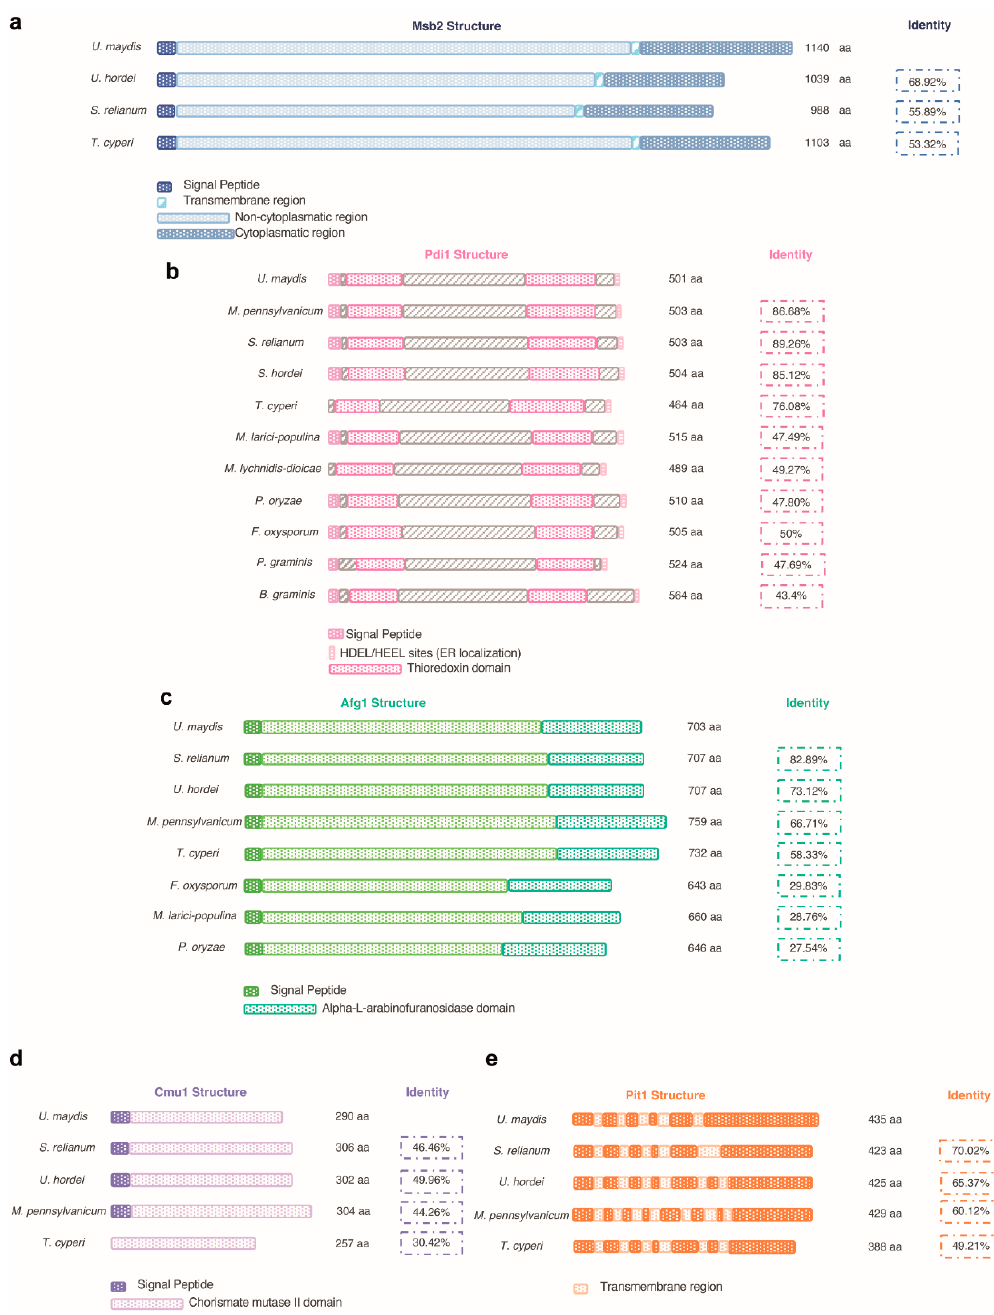
Figure 5. Schematic representation and conservation of Pmt4 putative targets across fungi. The percent identity of the protein was obtained using BlastP and is plotted to the right of each protein. Organisms used to study the conservation